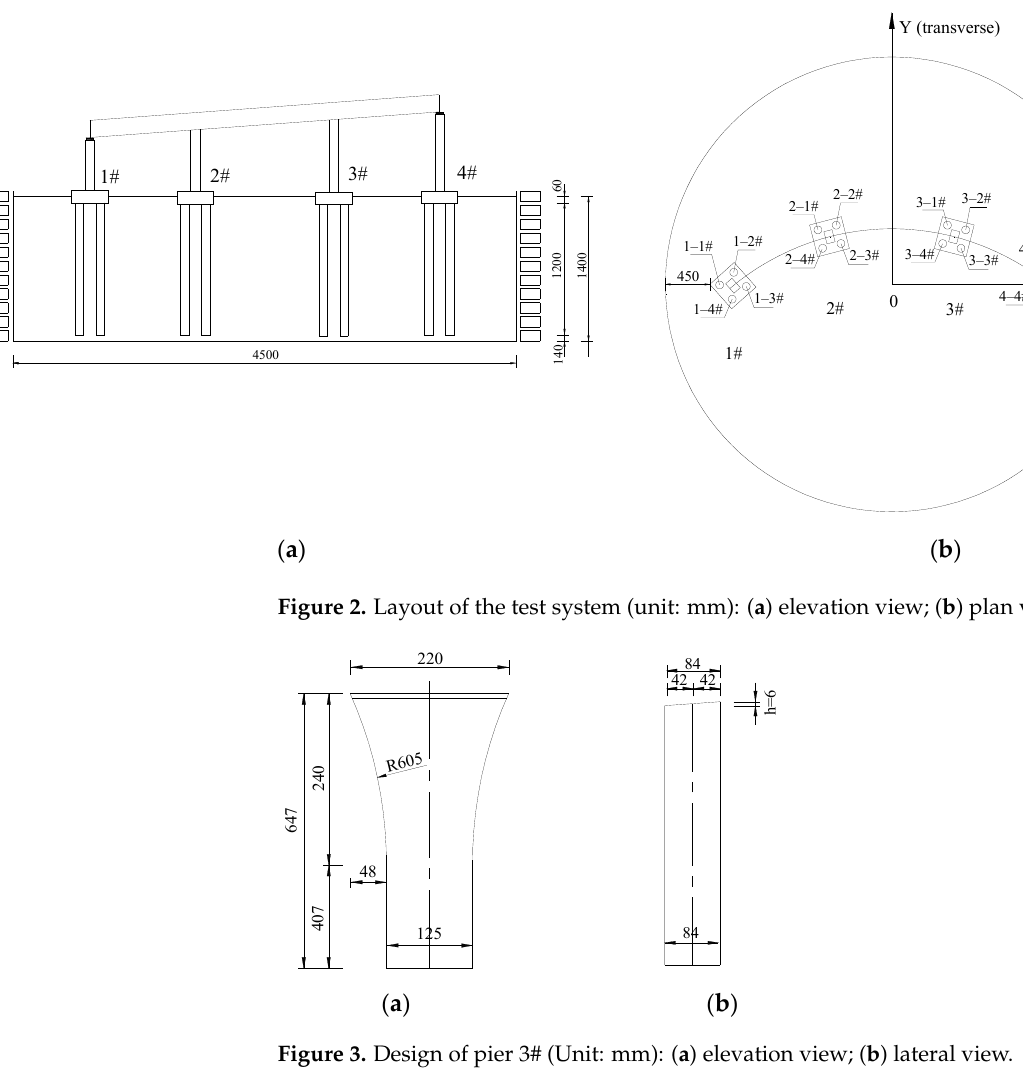
Figure 3. Design of pier 3# (Unit: mm): ( a ) elevation view; ( b ) lateral view.